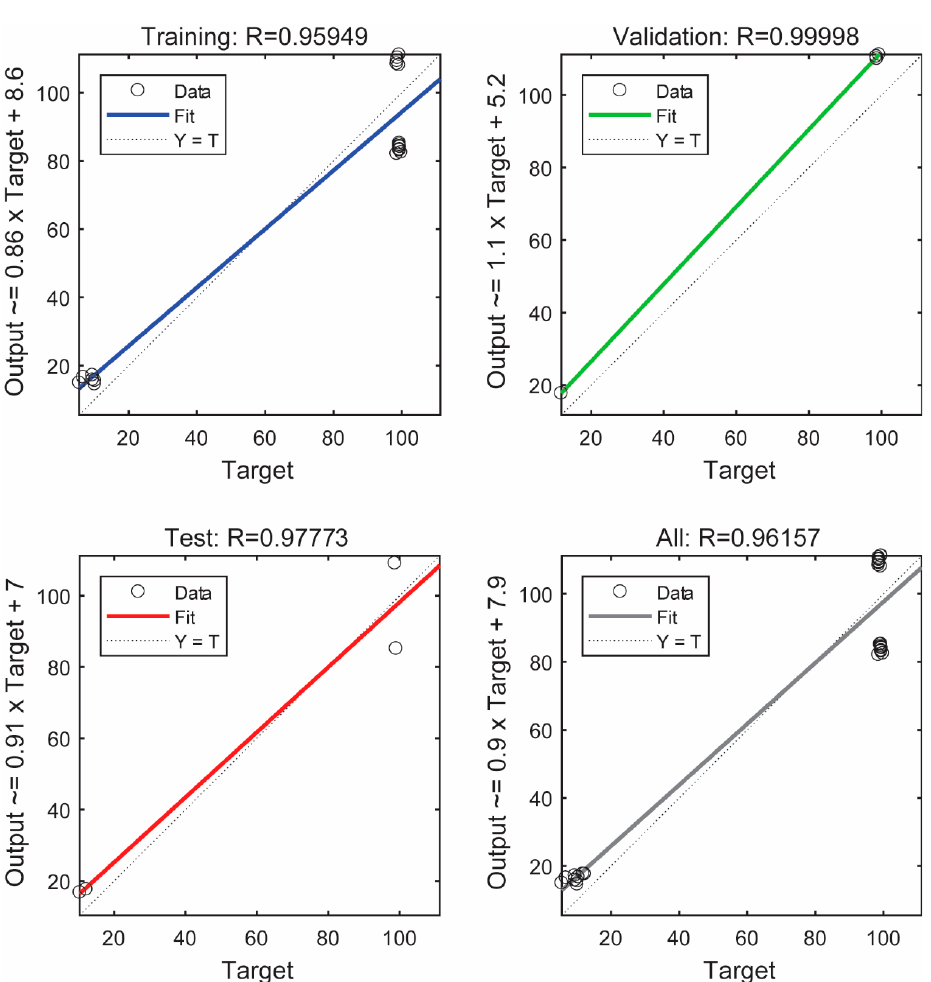
Figure 10. Training status in predicting the NO x conversion percentage, X : ( a ) Gradient ( b ) momentum term ( c ) validation checks.